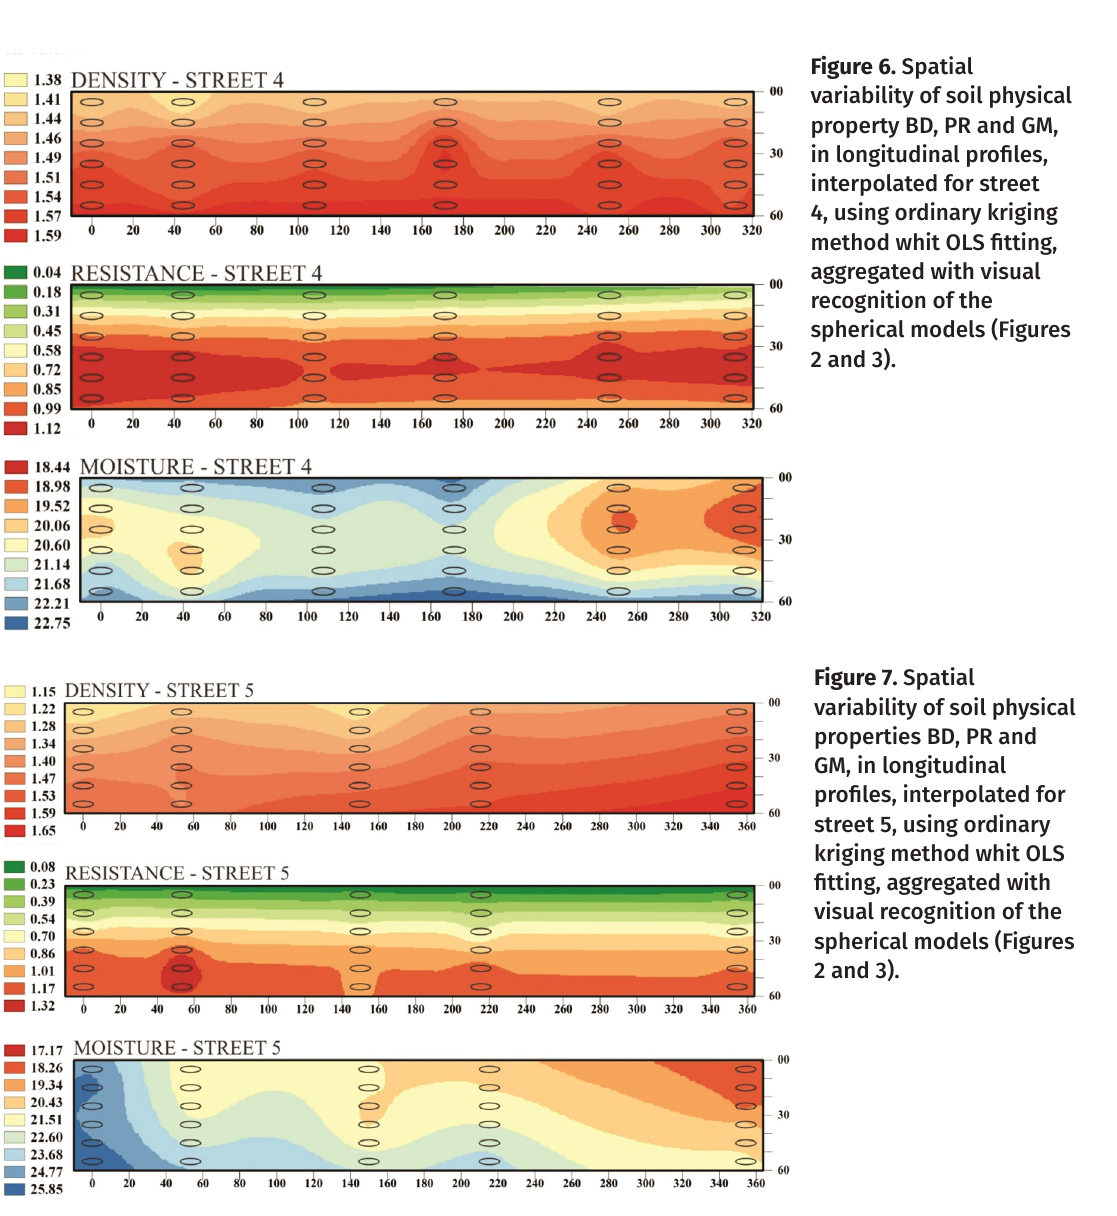
Figure 7. Spatial variability of soil physical properties BD, PR and GM, in longitudinal profiles, interpolated for street 5, using ordinary kriging method whit OLS fitting, aggregated with visual recognition of the spherical models (Figures 2 and 3).